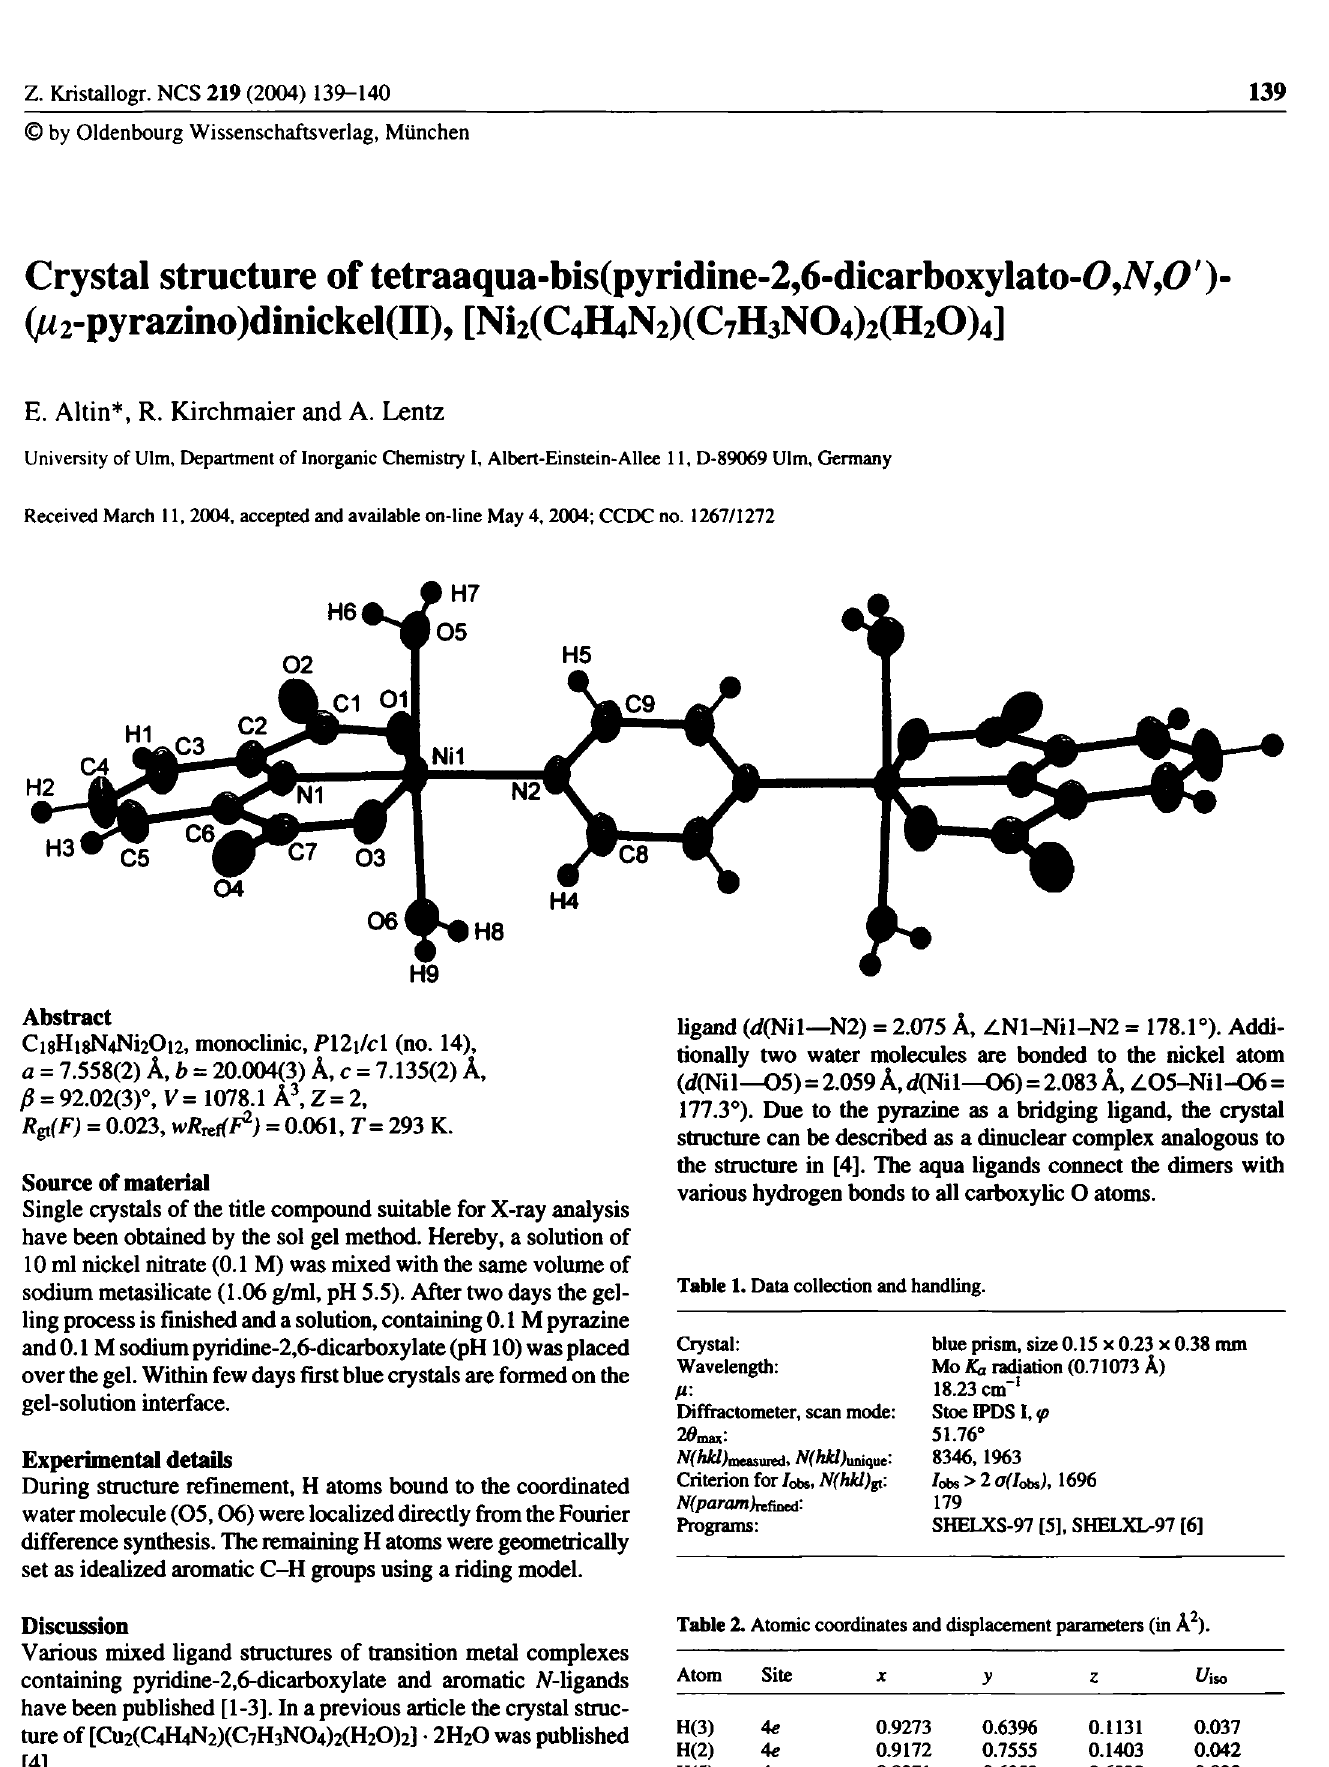
Table 2. Atomic coordinates and displacement parameters (in Â 2